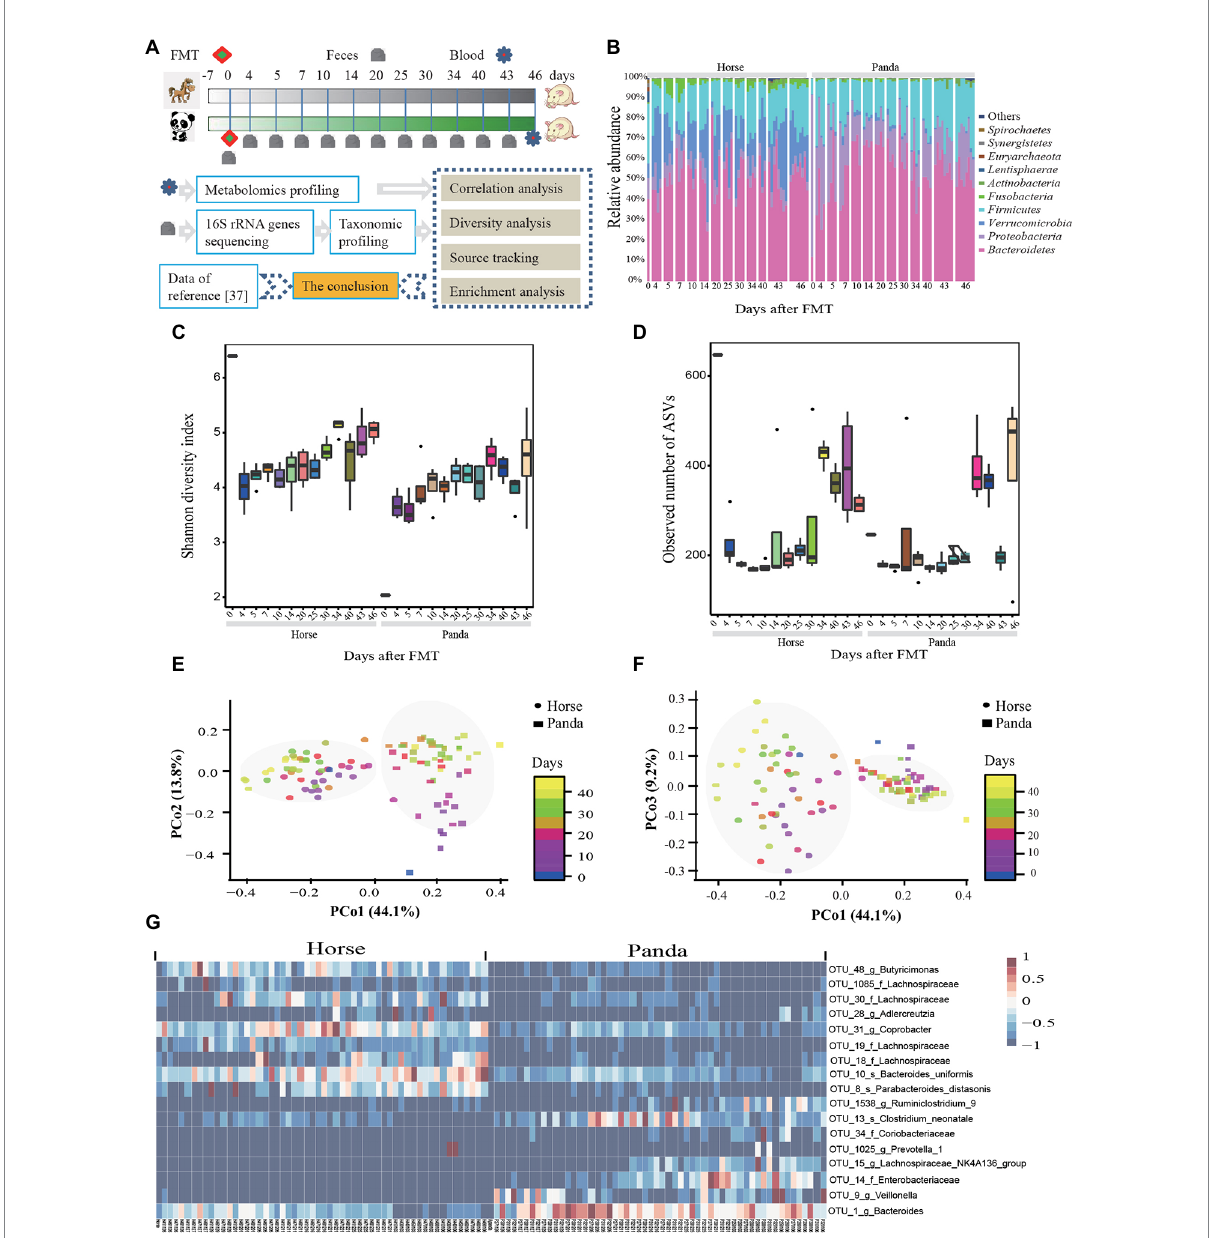
FIGURE 1 The composition and diversity of gut microbiota in germ-free mice. The experimental design of this study is shown in (A) . The conclusion was checked by comparing the data to the recent study by Huang et al. (2022). The composition and diversity included the relative abundance of bacteria of the top ten phyla (B) , Shannon diversity index (C) , the observed number of ASVs (D) , the PCoA plot with PCo1 and PCo2 (E) , the PCoA plot with PCo1 and PCo3 (F) , and the heat map of the 17 ASV-level phylotypes identified as key variables for differentiation gut microbiota structure between panda-mice and horse-mice (G) . Day 0 represents the donor microbiota. Each vertical column denotes one sample. PCoA plots were generated using Bray-Curtis distances of 16S rRNA gene sequences showing the mice microbiota separated by donor in the first axis and shifted with colonized time in the second and third axis and the percentage of variation explained by the plotted principal coordinates is indicated on the axes. Each point corresponds to a community differentiated by shape and collection time by color. An FDR-corrected Wilcoxon rank-sum test was used to determine significance and shown in Supplementary Tables S2–S3 for Shannon diversity (C) and the observed number of ASVs (D) (* p < 0.05, ** p < 0.01, and *** p <